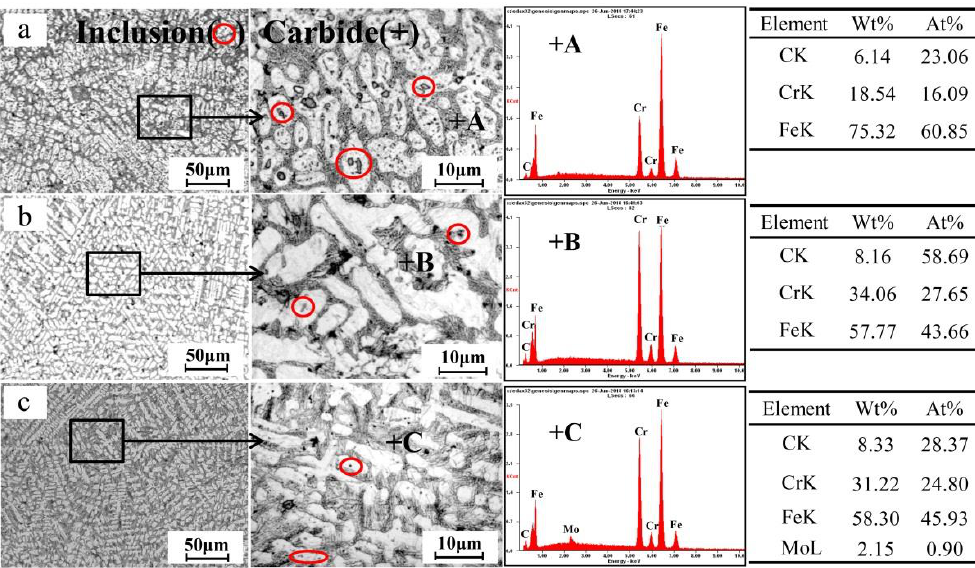
Figure 3. Microstructure and morphology of different surfacing layers and the energy-dispersive